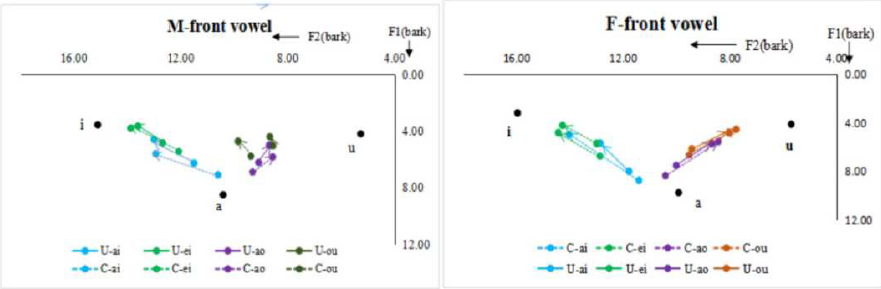
Fig. 4 Vowel chart of front vowel acoustics for intermediate level learners and standard